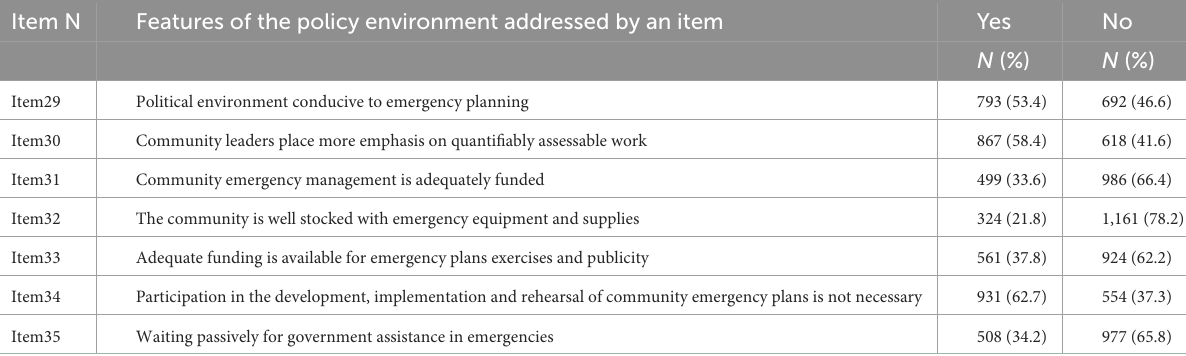
TABLE 5 Questionnaire responses to items about the “policy